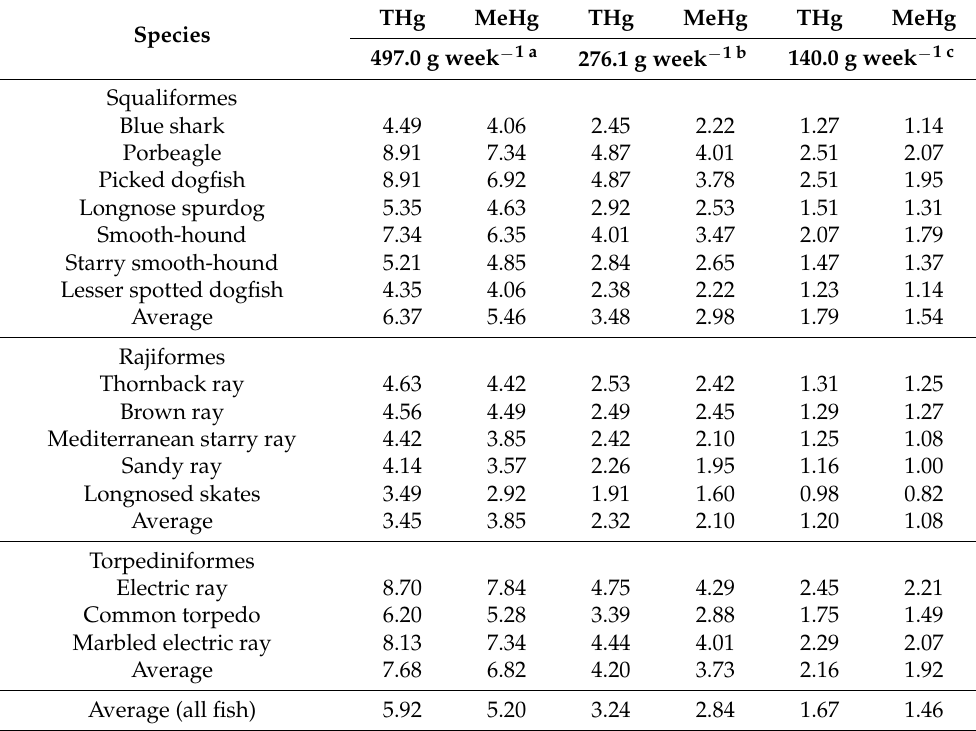
Table 2. Estimated weekly intakes (EWI: µ g kg − 1 bw week − 1 ) of total mercury (THg) and methylmer- cury (MeHg) from different fish consumption